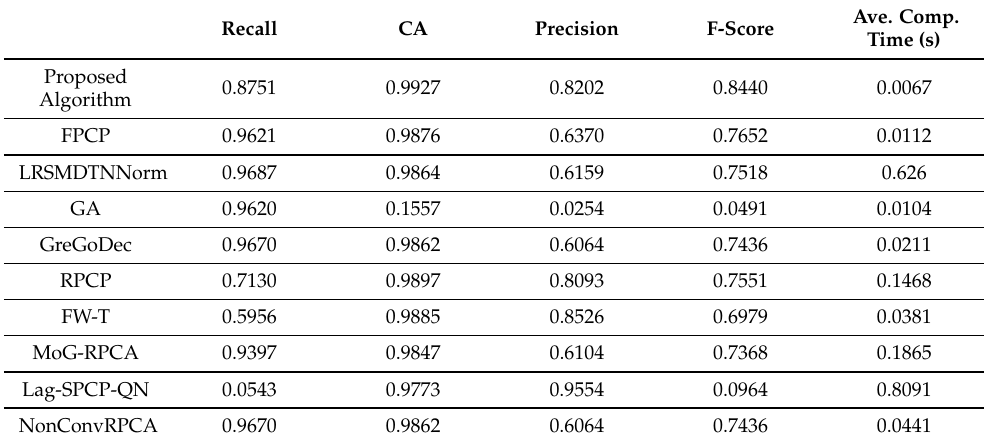
Table 5. Proposed technique foreground segmentation evaluation against different recent algorithms for Video